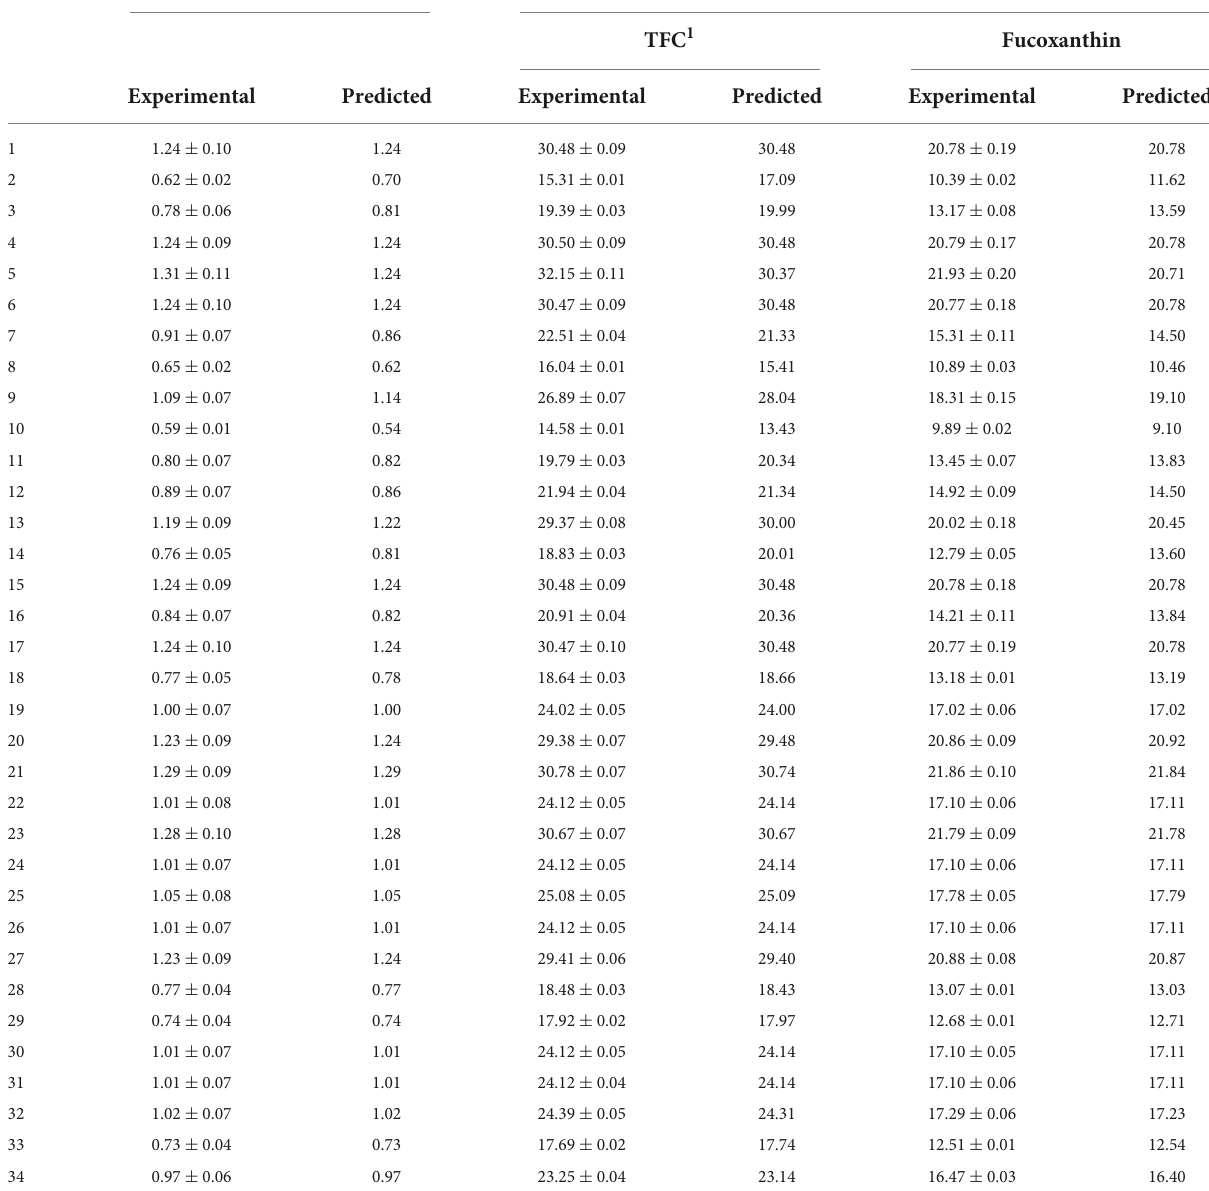
TABLE 3 Box–Behnken design of factors with total flavonoid content (TFC) and fucoxanthin based on experimental and predicted values under general particle size (450 µ m), CO 2 flow (2.5 ml/min), and entrainer (1.25